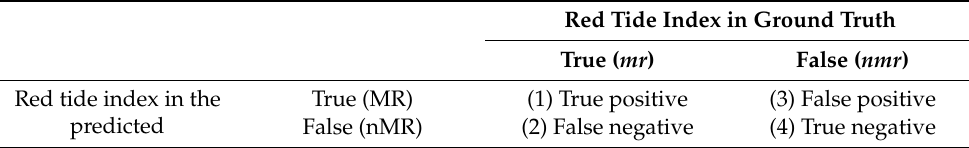
Table 4. A confusion matrix for evaluation of red tide detection